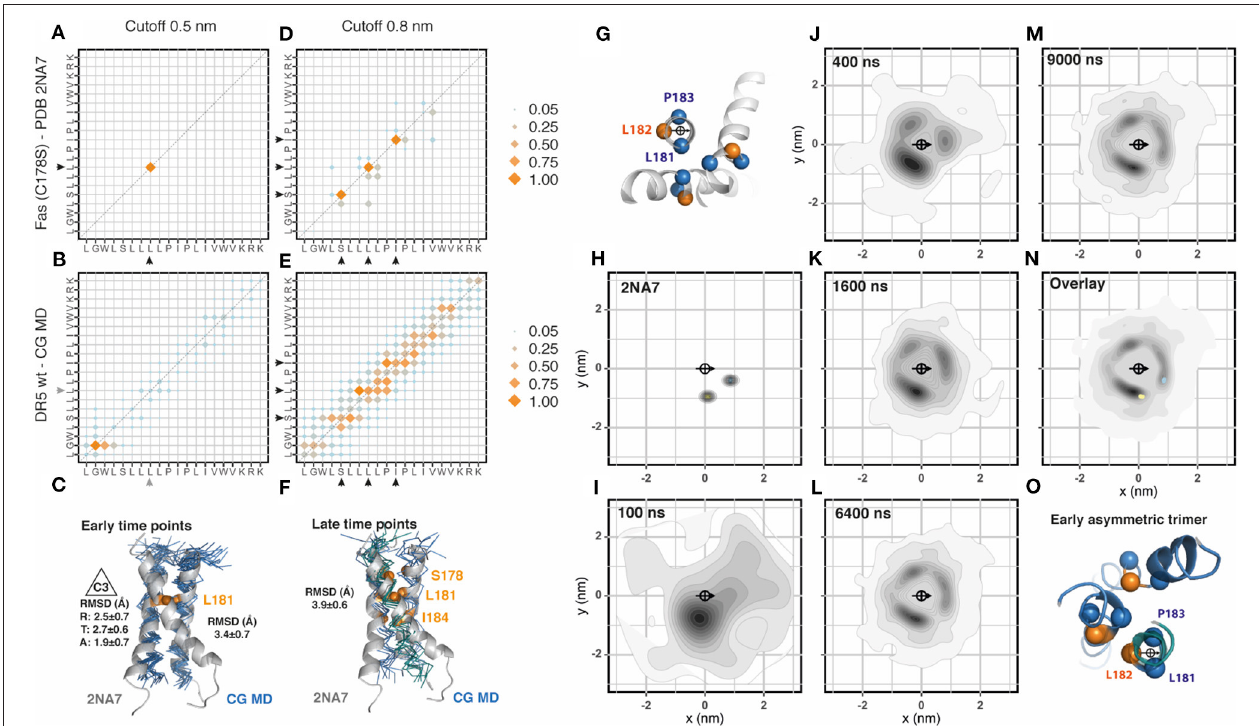
FIGURE 2 | Fas assembly. (A) Contact matrix of Fas C178S NMR (PDB:2na7) at 0.5nm cut-off distance. The amino acid sequence corresponds to residues L174 to K193. Black arrowheads indicate the residues involved in these interactions. Data corresponds to the averaged 15 NMR models. Scales correspond to the number of contacts normalized to the most frequent one. (B) Same as (A) , for Fas C178S CG-MD simulations. Gray arrowheads indicate non-conserved interactions observed only in the simulation. The analysis was performed on the full system (36 × 36) between 3 and 6 µ s. (C) Alignment of the Fas NMR average model with a Fas CG-MD dimer arranged in a 3-fold symmetry axes (C3). This structure is formed at early simulation times (0.5–1 µ s). The averaged root mean square deviation (RMSD) of the alignment is indicated on the right and the averaged radial (R), tangential (T), and axial (A) RMSD is indicated on the left. (D) Same as (A) , but using a cut-off distance of 0.8nm. (E) Same as (B) , but using a cut-off distance of 0.8nm. (F) . Alignment of the Fas NMR average model with a Fas CG-MD trimer, together with the analysis of the averaged root mean square deviation (RMSD) of the alignment. This structure is formed at late time points (5–6 µ s). (G) Residues chosen for the centroid and orientation vector used for radial distribution analysis. (H) Radial distribution analysis of the coarse grained Fas C178S NMR structure 2na7. The scale corresponds to the 2D-density function from the scatter plot, as described in Methods. (I–M) Radial distribution analysis of different snapshots of Fas C178S CG-MD at the indicated time points. (N) Overlay of the radial distribution of the reference structure (2na7, blue/yellow dots) and the CG-MD structures (gray density scale). (O) Example of an early trimer, where the third helix assembles in an asymmetric manner, generating the visible spot on top of the central